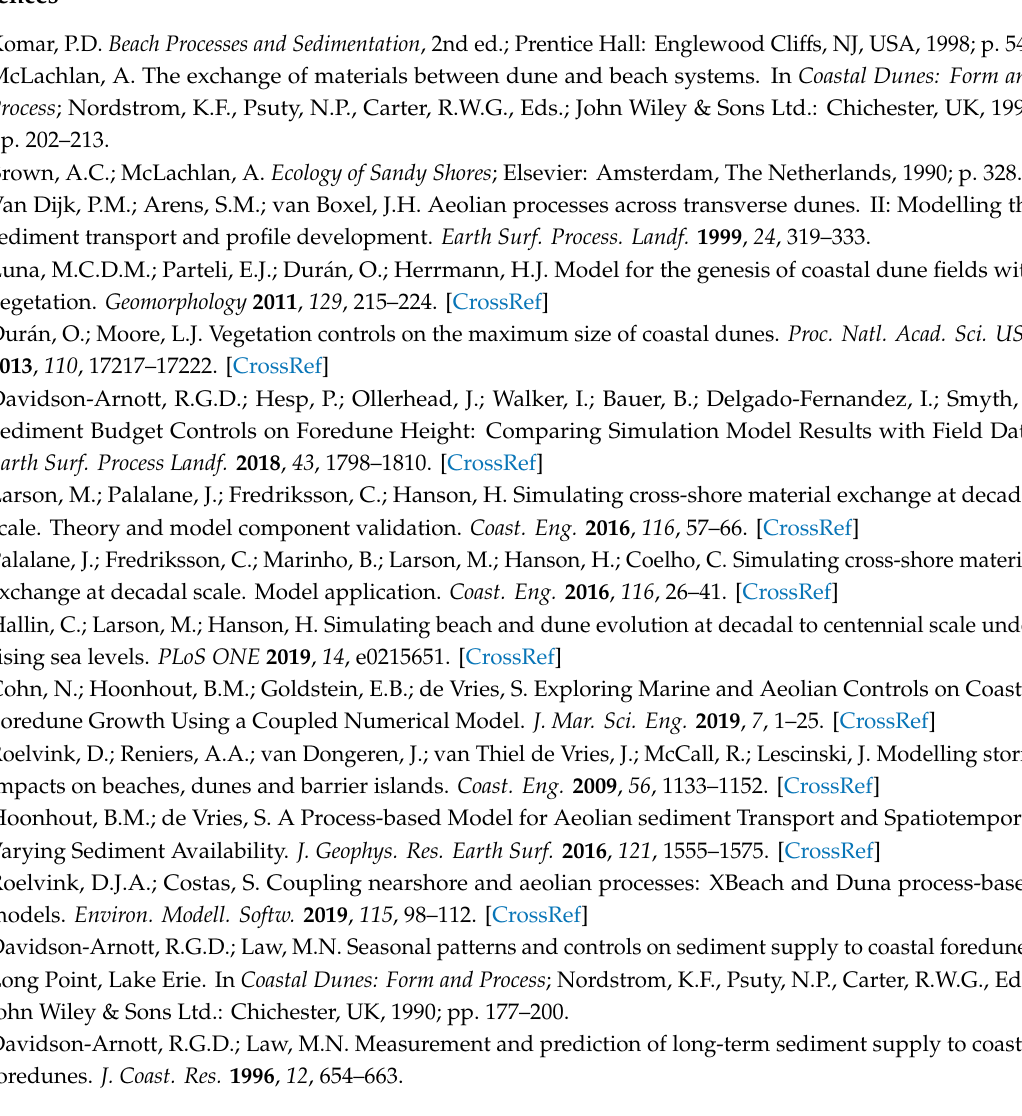
Figure 16. Correlation between the measured and simulated weekly averaged volume-change rates in the validation process. Figure 17. Time series of the measured and simulated cumulative volume changes in the validation process. Figure 18. The cumulative volume changes at the end of the investigation period simulated using the values of K, c1, and c2 that were increased and decreased by 10%. The broken line shows the volume simulated using the best-fit parameter values. Figure 19. Measured and simulated weekly averaged volume-change rates in the calibration process: (a) power spectral densities, (b) coherence, and (c) phase. Figure 20. Measured and simulated weekly averaged volume-change rates in the validation process: (a) power spectral densities, (b) coherence, and (c) phase. Figures in Appendix Figure A1. Correlation between reproduced and measured cross-shore wind velocities. The black line represents the linear correlation estimated by the least-squares method. Figure A2. Correlation between reproduced and measured alongshore wind velocities. The black line represents the linear correlation estimated by the least-squares